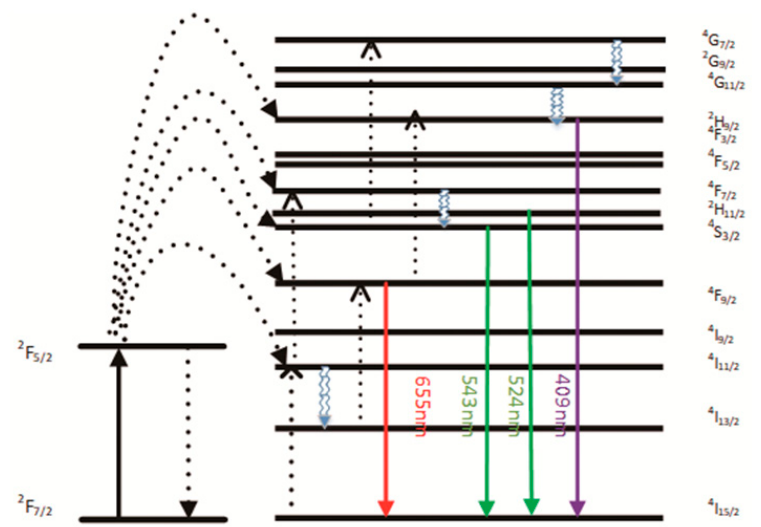
Figure 3. A simplified energy level diagram of the Er 3+ /Yb 3+ system doped with Au, and up- conversion pathways. The arrows represent the direction of electron migration, and the dashed and solid lines of the arrows represent the energy levels of the electron transitions. Arrows of different colors represent different wavelengths.